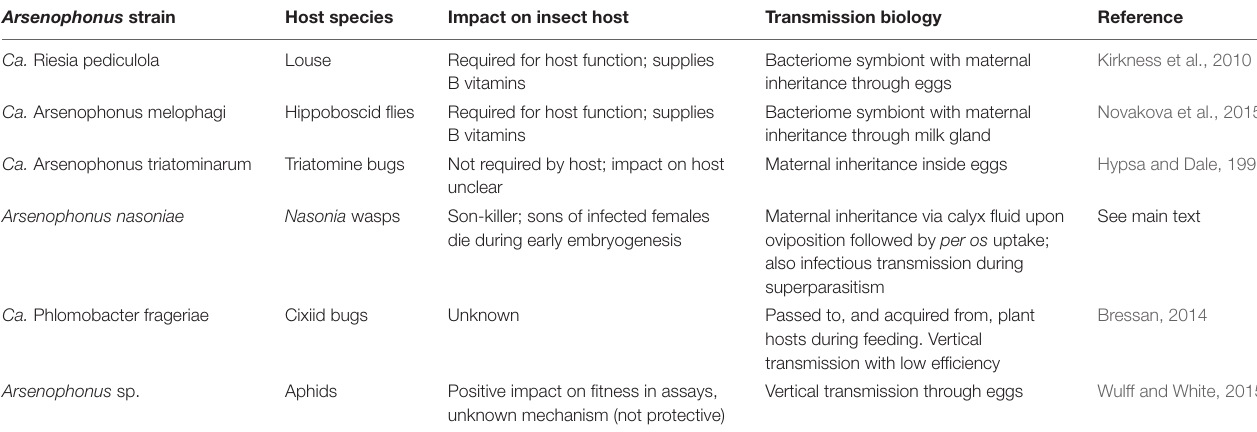
TABLE 1 | Diversity of Arsenophonus interactions with insects as exemplified by case